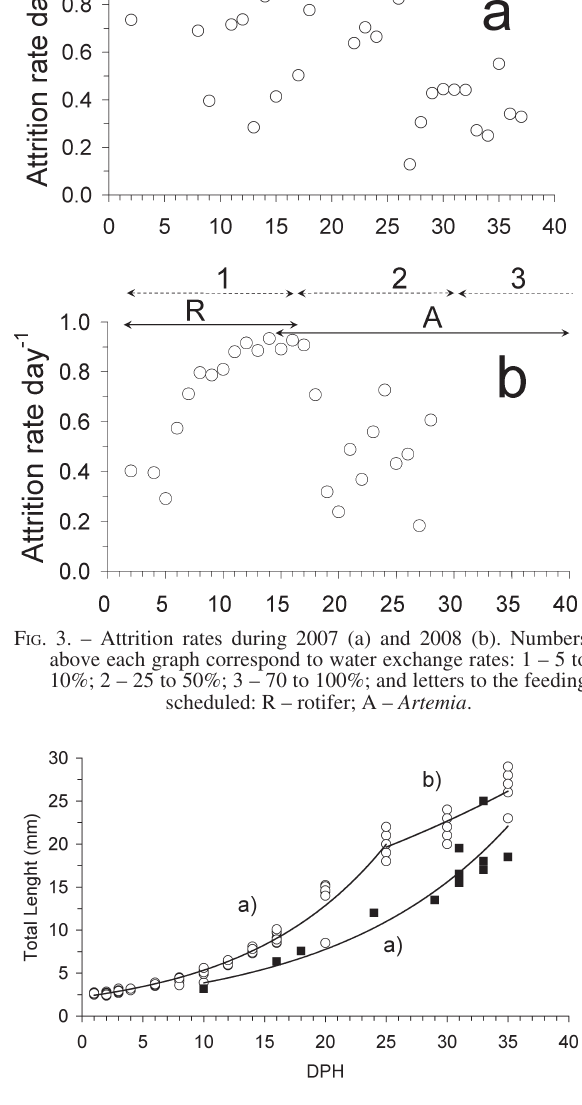
F ig . 4. – growth in length of dusky grouper larvae during 2007 (black squares) and 2008 (white circles). Exponential lines: a, before metamorphosis; b, during